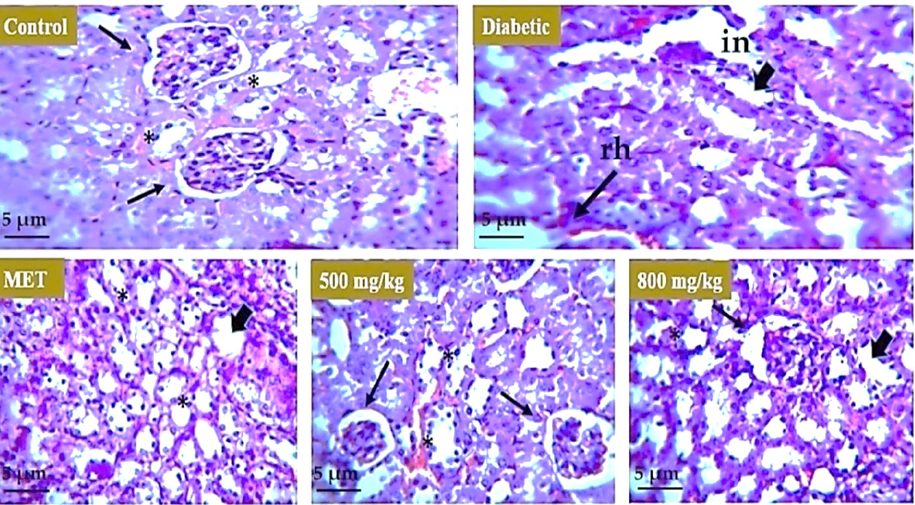
Figure 9. Effect of aqueous extract on the kidney. The kidney of the normal mice revealed intact glomeruli and tubular structure. The kidney of diabetic mice showed interstitial nephritis and renal hemorrhage (arrows). Metformin-treated mice showed little improvement in interstitial nephritis and renal hemorrhage. The 500 mg/kg TS-AQ dose-treated mice revealed significant improvement toward normal glomeruli structure and restoration in normal renal morphology (*). The 800 mg/kg TS-AQ-treated mice also showed little improvement in restoring kidney normal internal structure and tubules. in = interstitial nephritis. rh = renal hemorrhage.